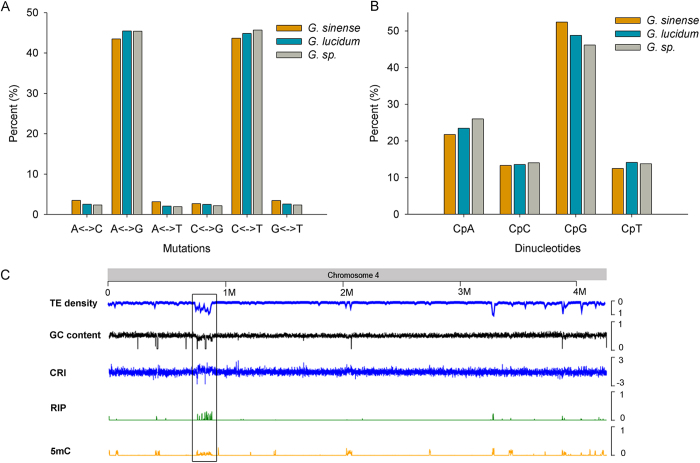
The characteristics of the RIP mutations.A) The mutation types investigated in the TEs in G. sinense, G. lucidum and G. sp. B) The dinucleotide patterns for RIP. The frequencies of dinucleotides in each CpN dinucleotide were assessed in G. sinense, G. lucidum and G. sp. C) The enrichment of RIP and 5 mC on chromosome 4. The density of TEs is shown at the top of the graph. The base composition (GC%), a composite RIP index (CRI), plotted in moving 500 bp windows with 100 bp steps, are shown. The RIP and 5 mC, also calculated in the above windows, are shown with their densities for each window at the bottom.